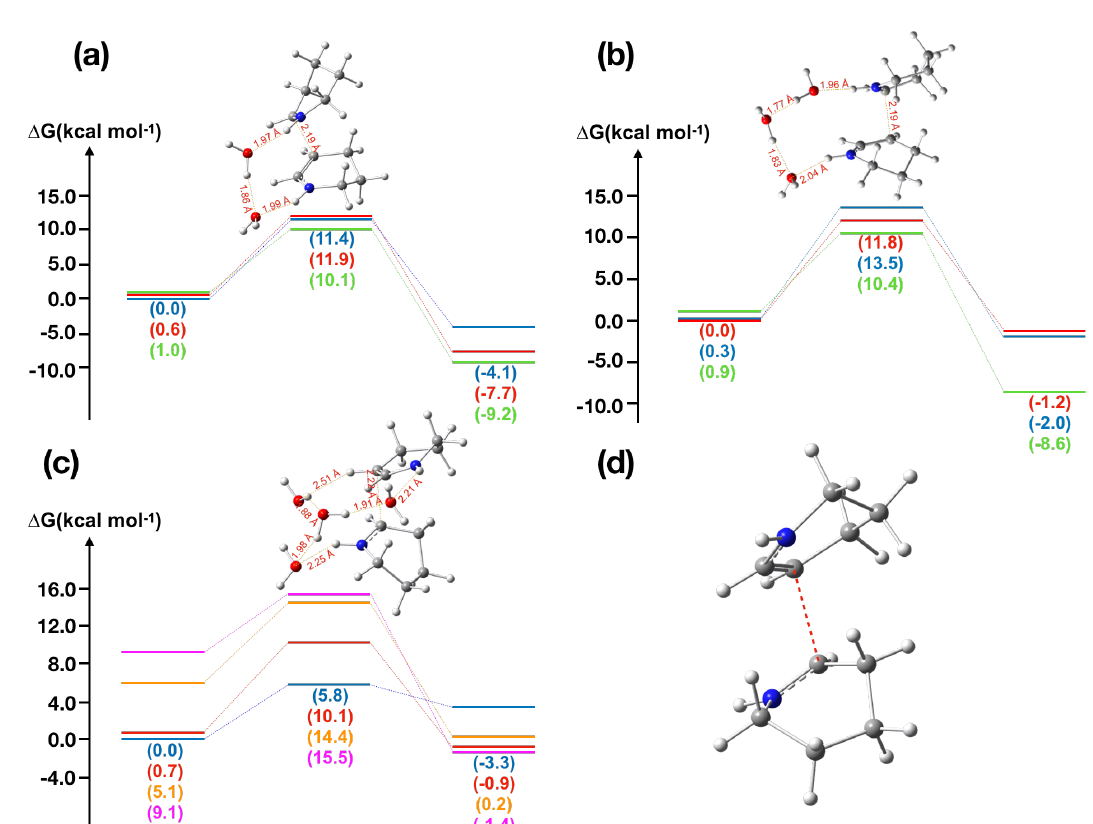
Figure 2. Computed energy profiles for ∆ 1 -piperideine dimerization reaction under acidic conditions, where green and red lines are for ( R,S )-piperideine dimers and blue, orange and purple lines are for ( S,R )-piperideine dimers: ( a ) dimerization with two molecules of water; ( b ) dimerization with three molecules of water; ( c ) dimerization with four molecules of water; and ( d ) transition state structure of piperideine dimerization reaction under acidic